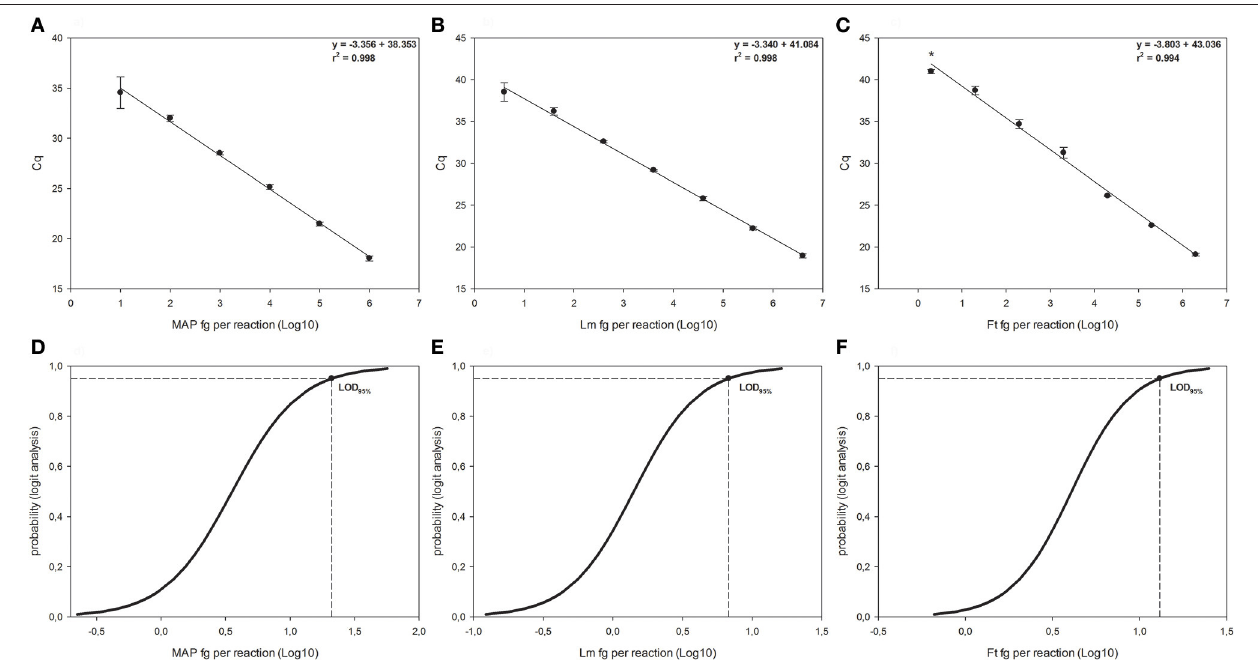
FIGURE 1 | Linear regressions and Logit analysis plots of the three qPCRs used in the study. Panels (A,D) are referred to Mycobacterium avium subsp. paratuberculosis (MAP), panels (B,E) are referred to Listeria monocytogenes (Lm) and panels (C,F) to Francisella tularensis (Ft). The number of replicates used for the evaluation of the panels (A–C) is reported in material and method section. In the right side of each graph are reported the first-grade equation as well as the r 2 values. *Indicates 2/10 replicates were positive. Bars represent standard deviation. Panels (D–F) show the LOD 95 % for each qPCR, which are theminimum amounts of DNA detectable with a 95%